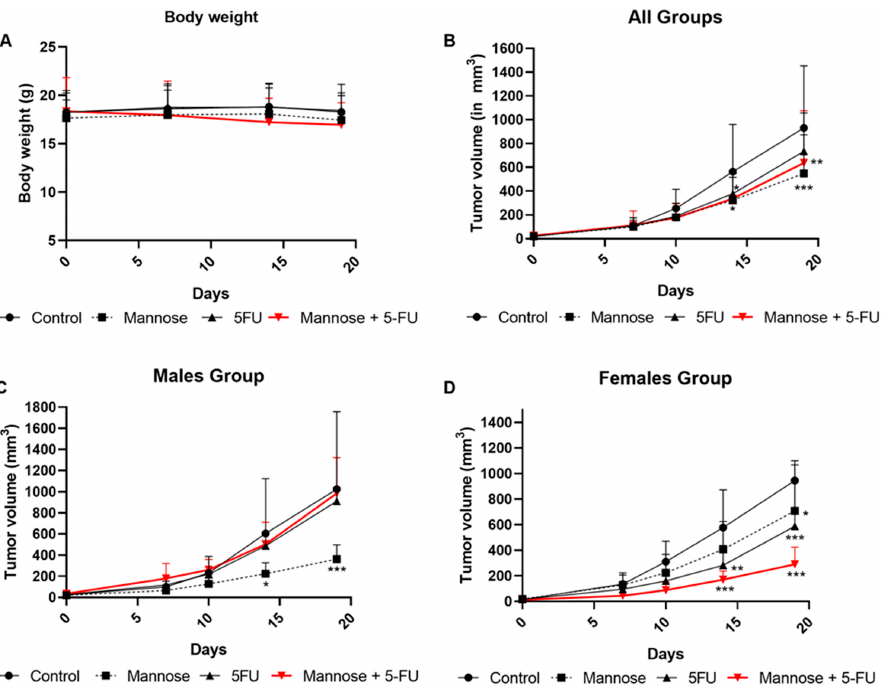
Figure 9. Body weights and tumor volumes of NOD/SCID mice treated with mannose alone, 5-FU, or in combination. Here, 5 × 10 6 HCT116 cells were injected subcutaneously into the fl ank of NOD/SCID mice. After tumor development, mice were divided into 4 groups: control, mannose, 5-FU, and mannose/5-FU. ( A ) Body weights were measured over time and represented among the four groups. Tumor volumes were measured over time and represented among the four groups, including ( B ) males and females, ( C ) males only, and ( D ) females only. * p < 0.05, ** p < 0.01, and *** p < 0.001 are considered statistically signi fi cant.